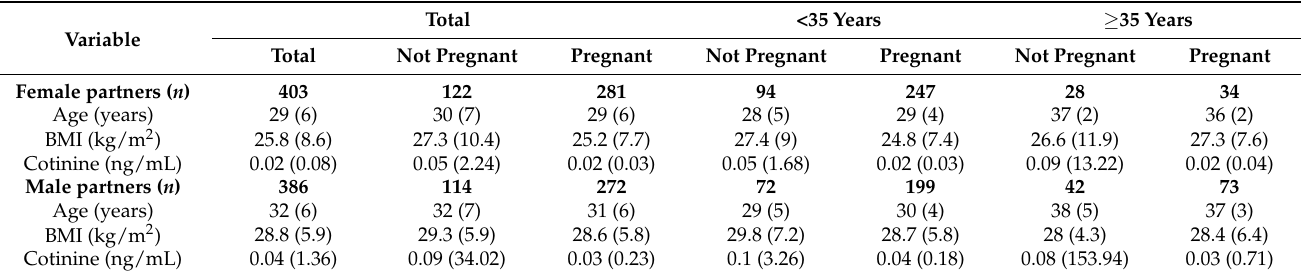
Table 1. Covariate summary statistics [median (interquartile range)] by pregnancy status, age category, and sex among participants in the Longitudinal Investigation on Fertility and Environment Study in Michigan and Texas